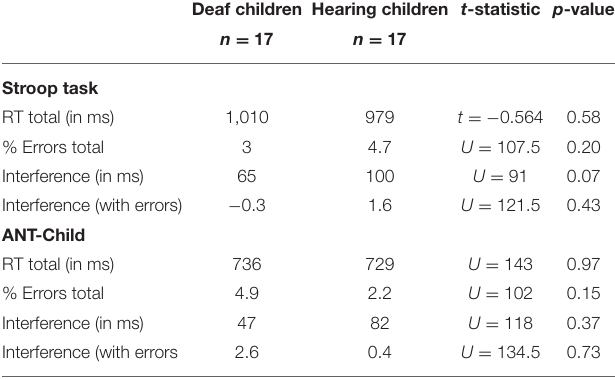
TABLE 3 | Results of inhibitory control tasks.